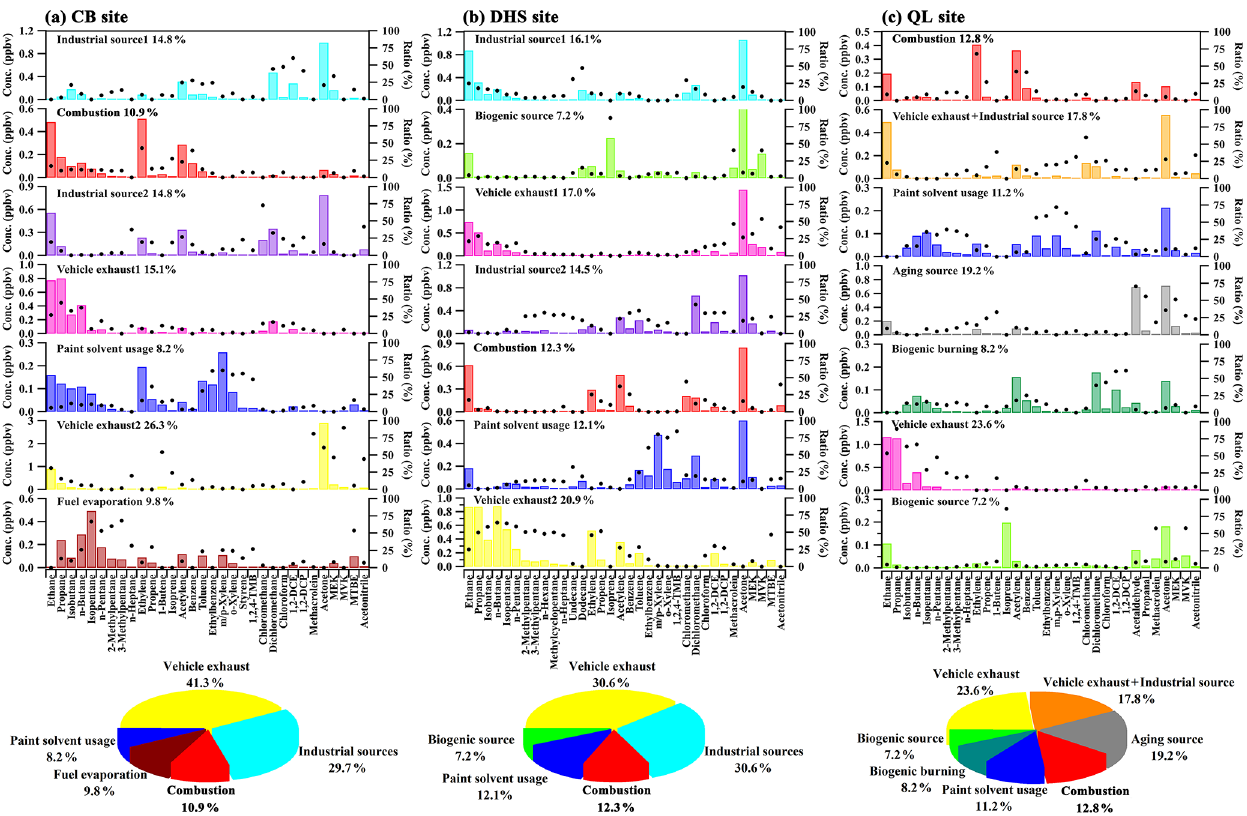
Figure 8. Source profiles and contributions of VOCs in the CB, DHS, and QL sites during the observation period. Bars represent the concentration of each species apportioned to the factor, and black dots represent the percent of each species apportioned to the